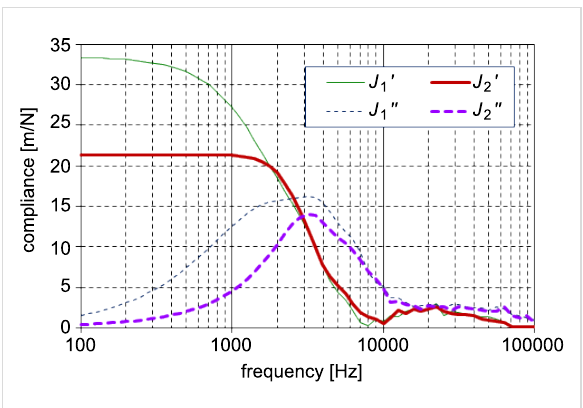
Figure 6: Complex compliance of cantilever–water system calculated by Fourier–Laplace transformation of the response signals in Figure 5(a) and Figure 5(b). The solid and broken lines indicate the real and imaginary parts, respectively, and the fine and thick lines the data at 300 nm and in close proximity,